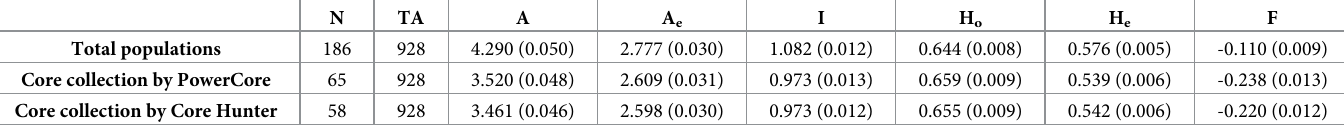
Table 7. Comparison of genetic diversity indexes between core collections developed using PowerCore and Core Hunter against the entire Nigerian-based germplasm. N